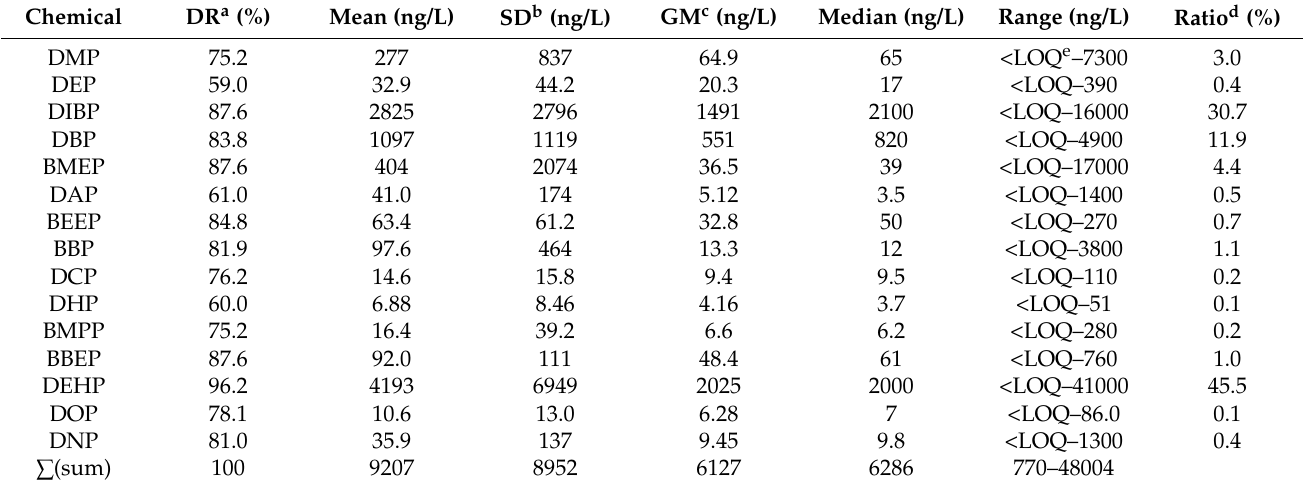
Table 1. Overall concentrations of phthalates in bottled drinks ( n = 105) collected from Dalian, Liaoning Province,